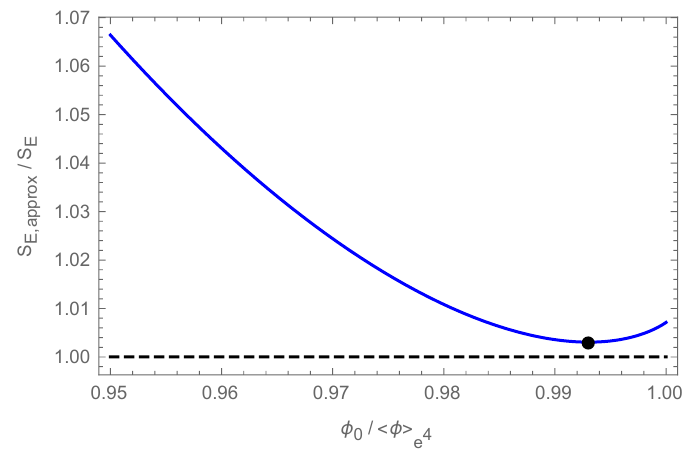
by the broken minimum of V and the action 0 e 4